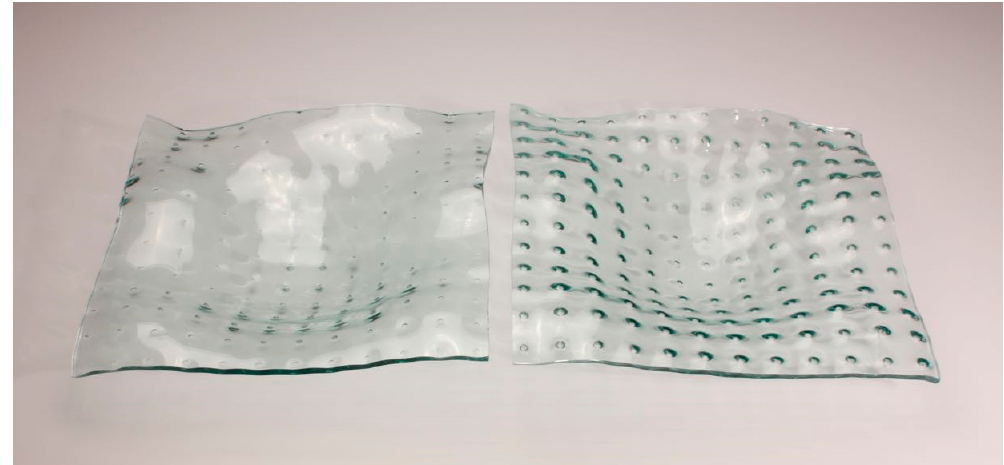
Figure 8. Early experiments using a full matrix of pins. This produced glass pieces with multiple indentations resulting from the pin tool, (photo: Jorgensen, T. 2010).